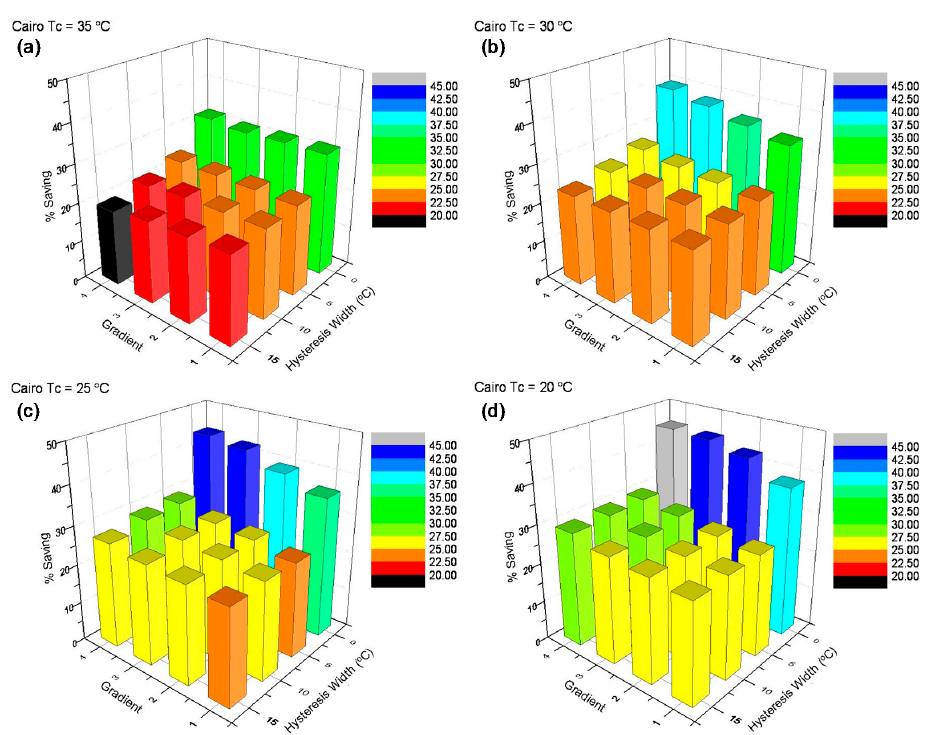
Figure 7. The graphs show the percentage reduction in energy demand for systems with varying values of T c , hysteresis width and values of T c , hysteresis width and gradient.